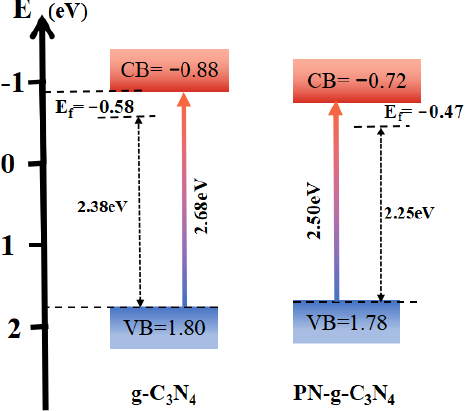
Figure 9. The schematic illustration of the band gap structures of g-C 3 N 4 and PN-g-C 3 N 4 sam- ples.